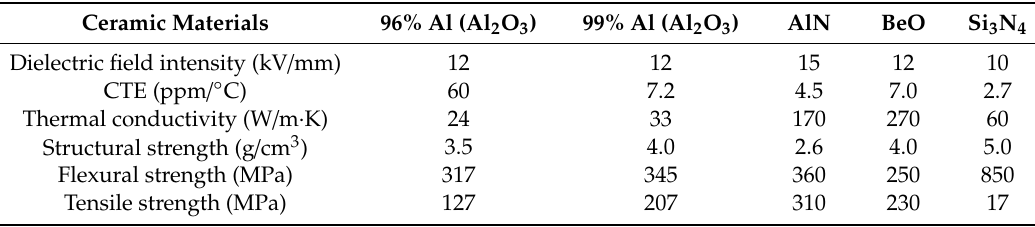
Table 3. The thermal mechanical characteristics of materials for the substrate